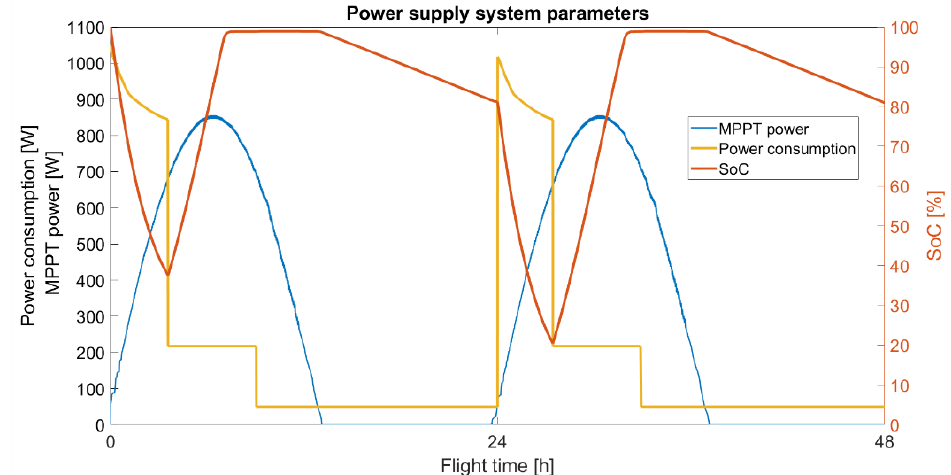
Figure 28. TwinStratos 12 15 km scenario in the vernal equinox.